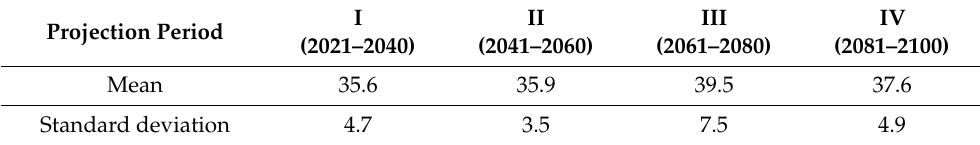
Figure 5. Future discharge simulation results of the Hanseok SHP plant basin. ( a ) Monthly average discharge: Period I (2021–2040), ( b ) monthly average discharge: Period II (2041–2060), ( c ) monthly average discharge: Period III (2061–2080), ( d ) monthly average discharge: Period IV (2081–2100), ( e ) annual average discharge. Table 6. Future runoff statistics in the Hanseok SHP plant basin [Unit: m (cid:2871) /s ]. Table 5. Future runoff statistics in the Deoksong SHP plant basin [Unit: m 3 /s ].